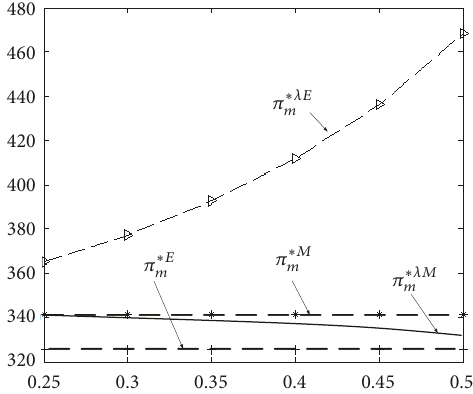
Figure 7: Change rule of service level as 𝜆 changes.